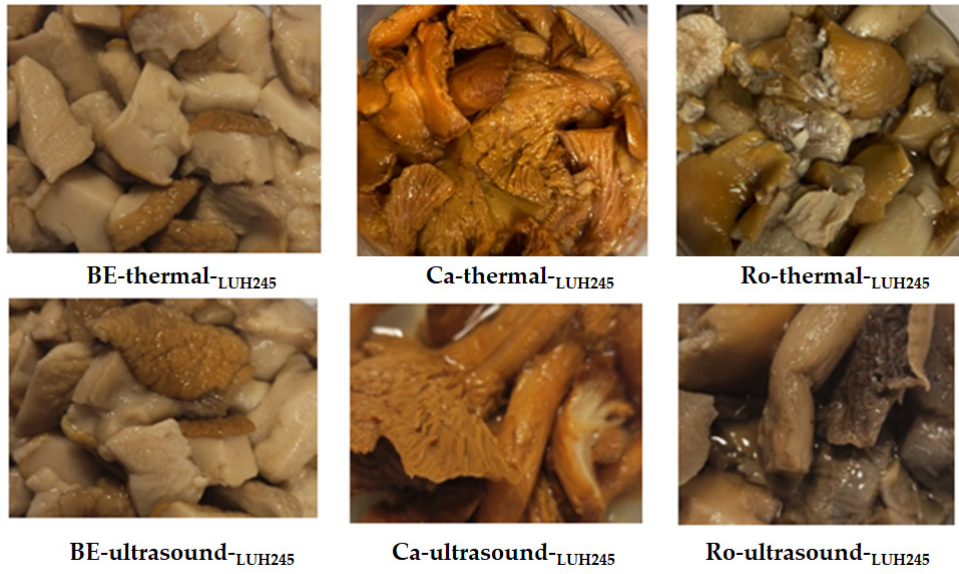
Figure 4. Images of edible mushrooms fermented for 7 days with L. uvarum LUHS245 (BE— Boletus edulis ; Ca— Cantharellus ; Ro— Rozites caperata